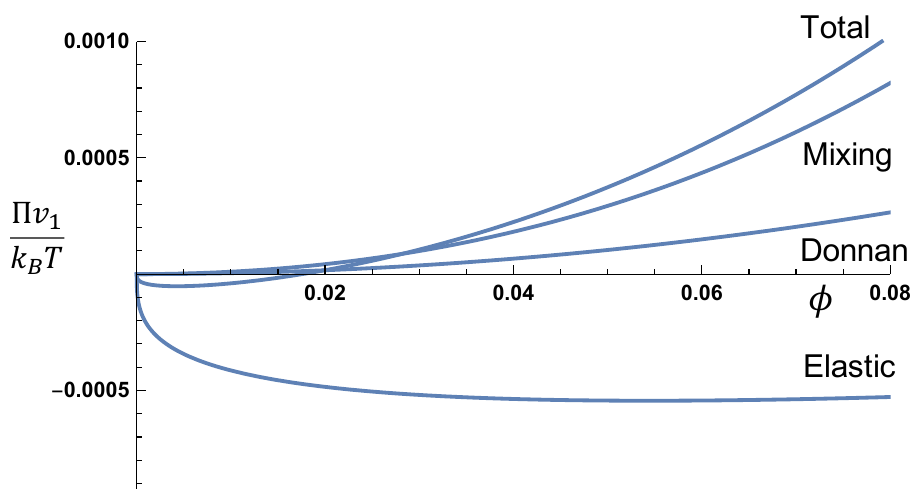
Figure 2. Contributions of mixing, Donnan, and elastic terms to the total osmotic pressure Π v 1 / k B T at c s = 0.1 M. ( χ = 0.4, α = 0.1, z p = 1, v 1 = 1nm 3 , φ 0 = 0.1, and N = 100.)